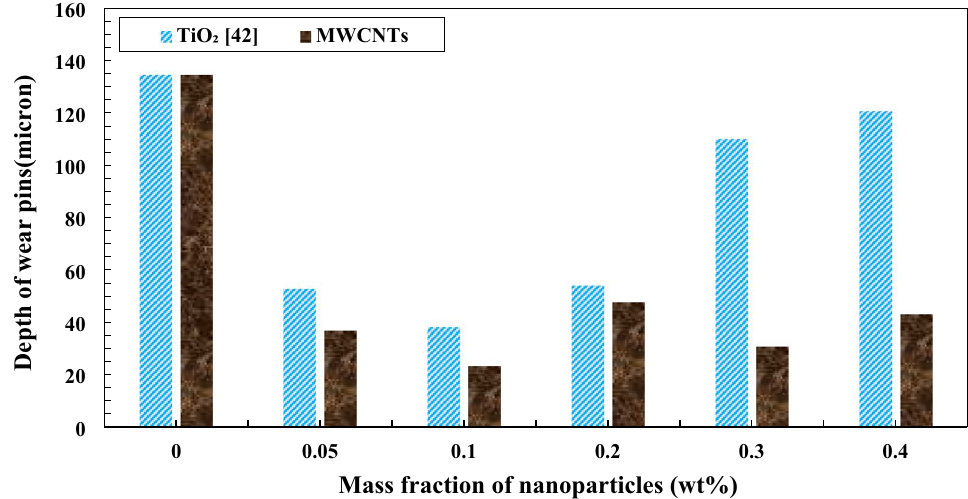
Figure 18. Comparison of the wear depth of copper pins with the addition of MWCNTs andTiO 2 to the pure